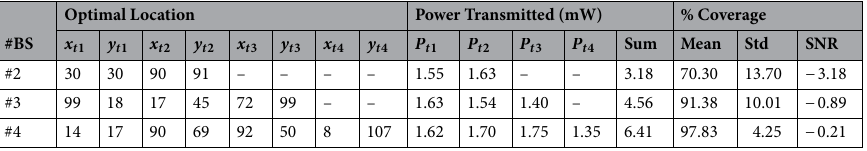
Table 3. The optimal results with the highest SNR among 10 repetitions of proposed algorithm for placement of two, three, four transmitting antennas ( β = 0.3, α = 0 ).